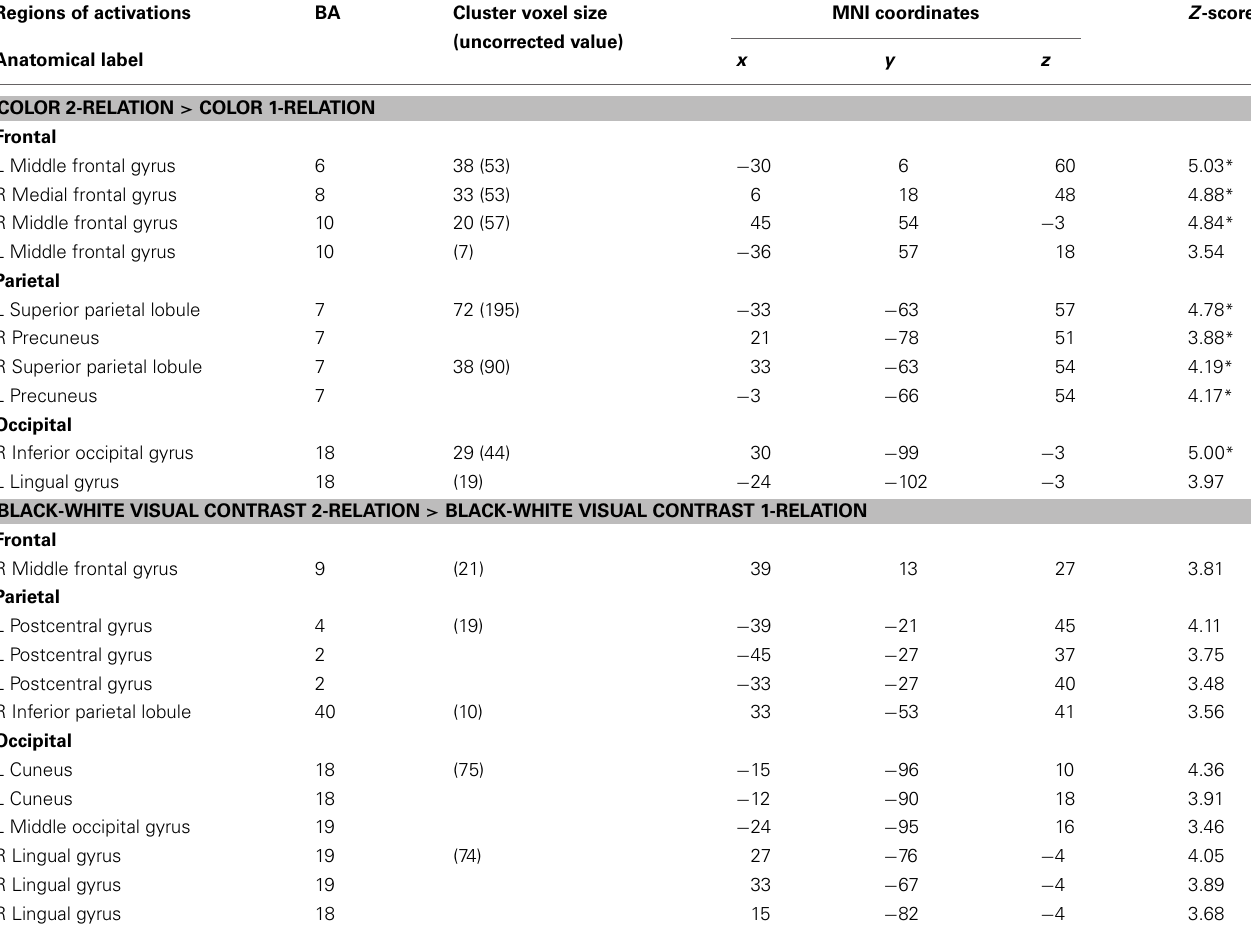
Table 3 | Influence of visual properties on neural systems of relational complexity—neuroanatomical results for the random-effects analysis within Color and BWVC conditions.